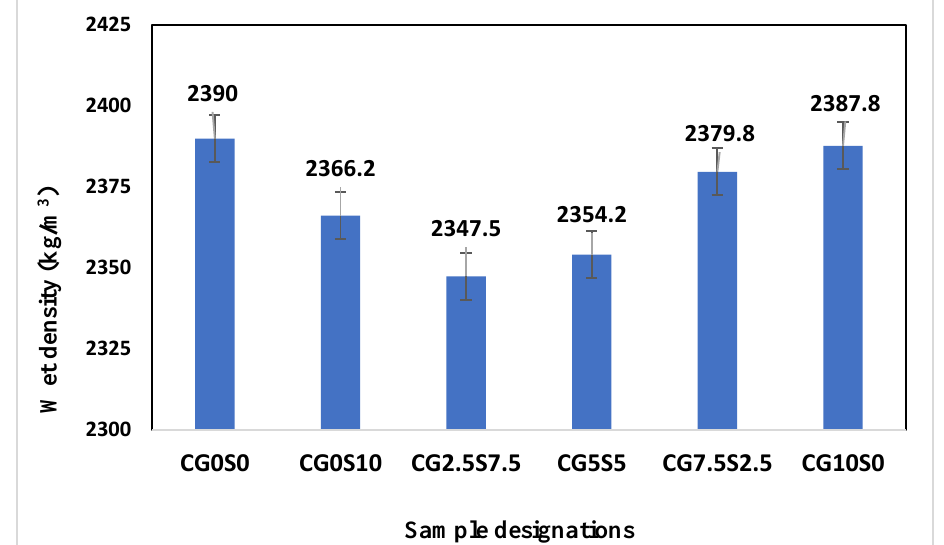
Figure 7. Density of the fresh blended silica-fume/glass concrete.